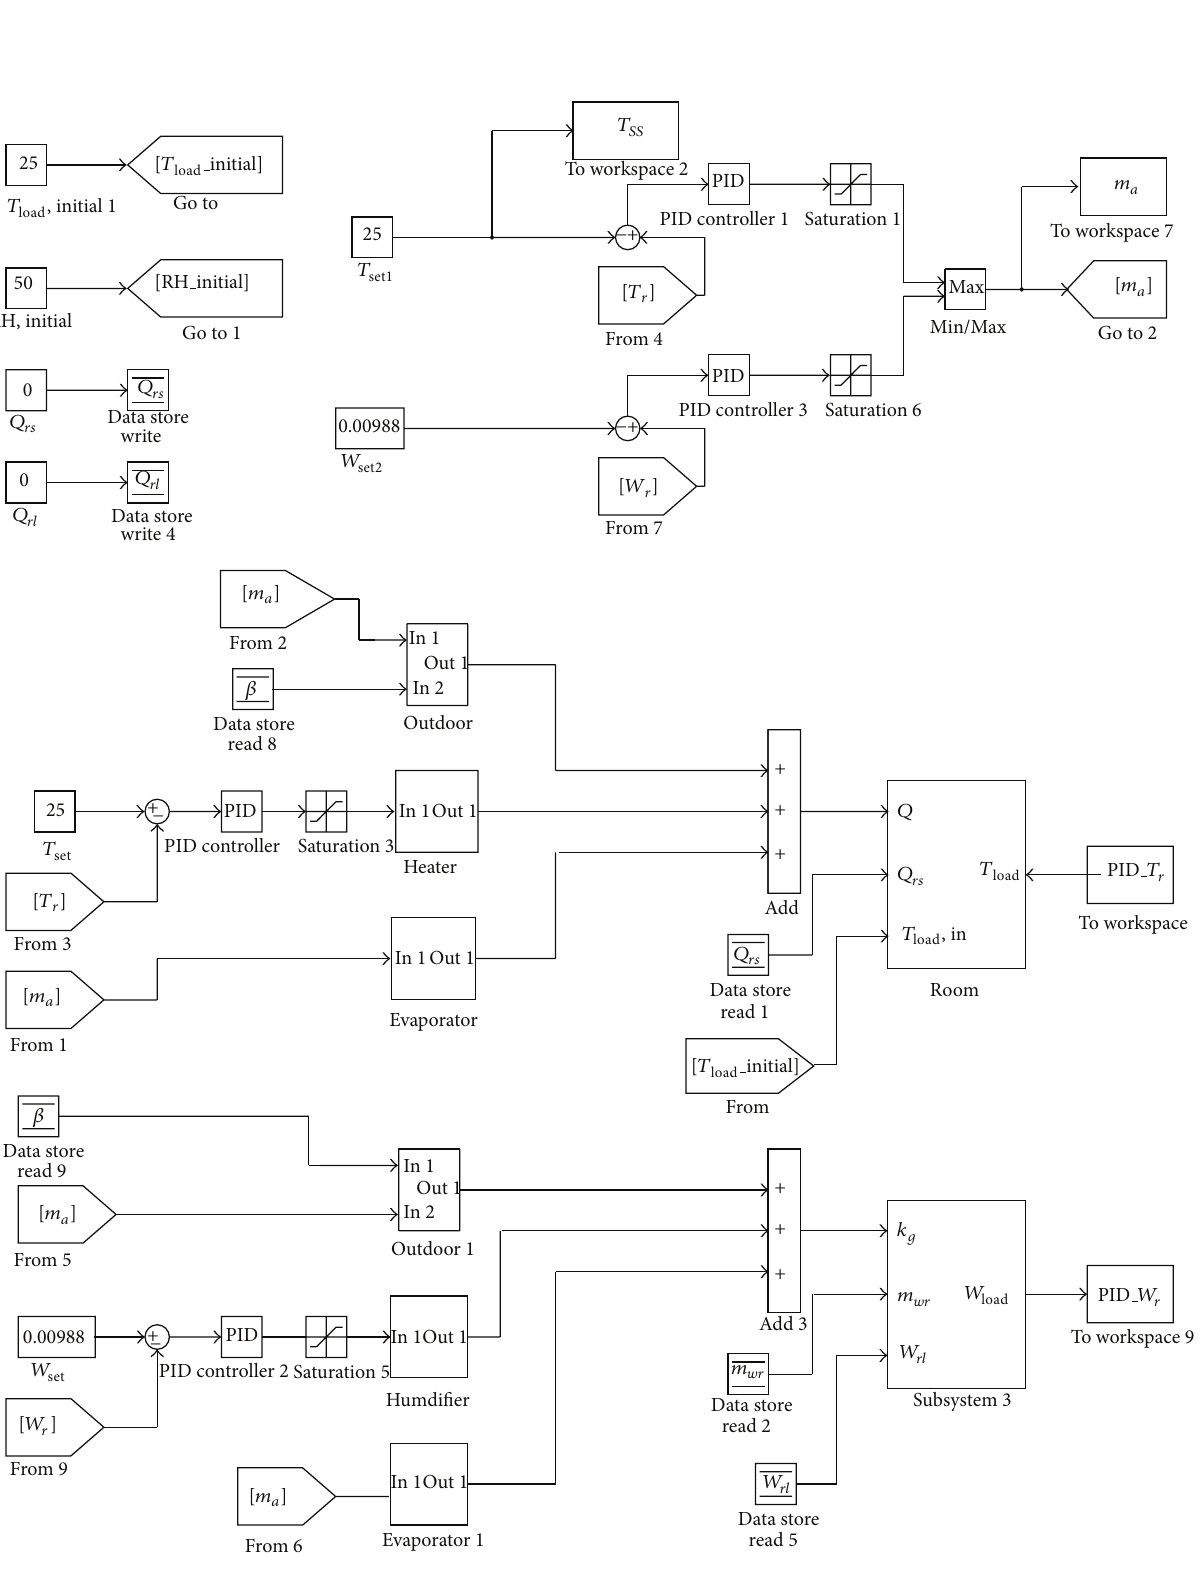
Figure 10: Schematic block diagram of PID control for the proposed